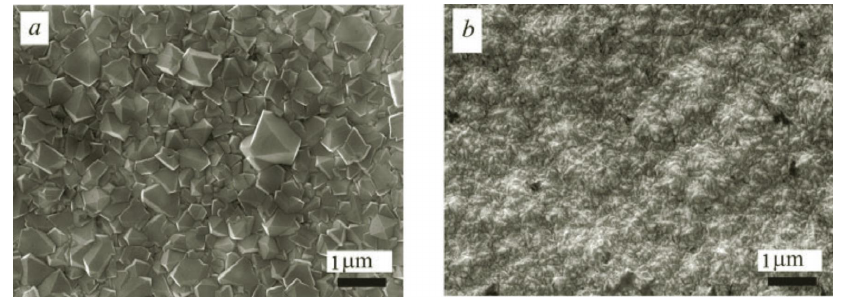
Figure 5. SEM images of diamond coatings (DC) deposited at a concentration of methane in the gas mixture: ( a ) 4% (microcrystalline DC) and ( b ) 15% (nanocrystalline DC) [20].